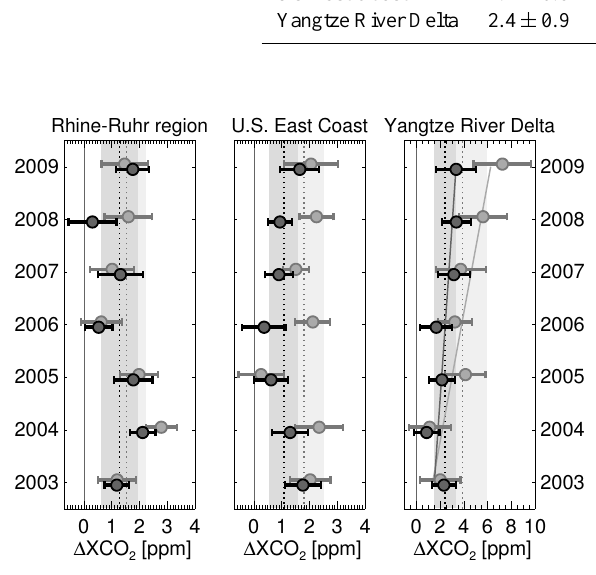
Fig. 6. Comparison of the retrieved yearly enhancements for the discussed source regions relative to the respective reference regions for the original data set (grey) and the biospheric corrected anoma- lies (black), which are obtained by subtracting large-scale regional monthly means from the single measurements. The dotted lines represent the mean enhancements averaged over all years and the shaded areas the corresponding standard deviations. Also shown are the linear fits demonstrating the positive trend of the Yangtze River Delta enhancement. Quantitative estimates of retrieved en- hancements and corresponding trends are listed in Table